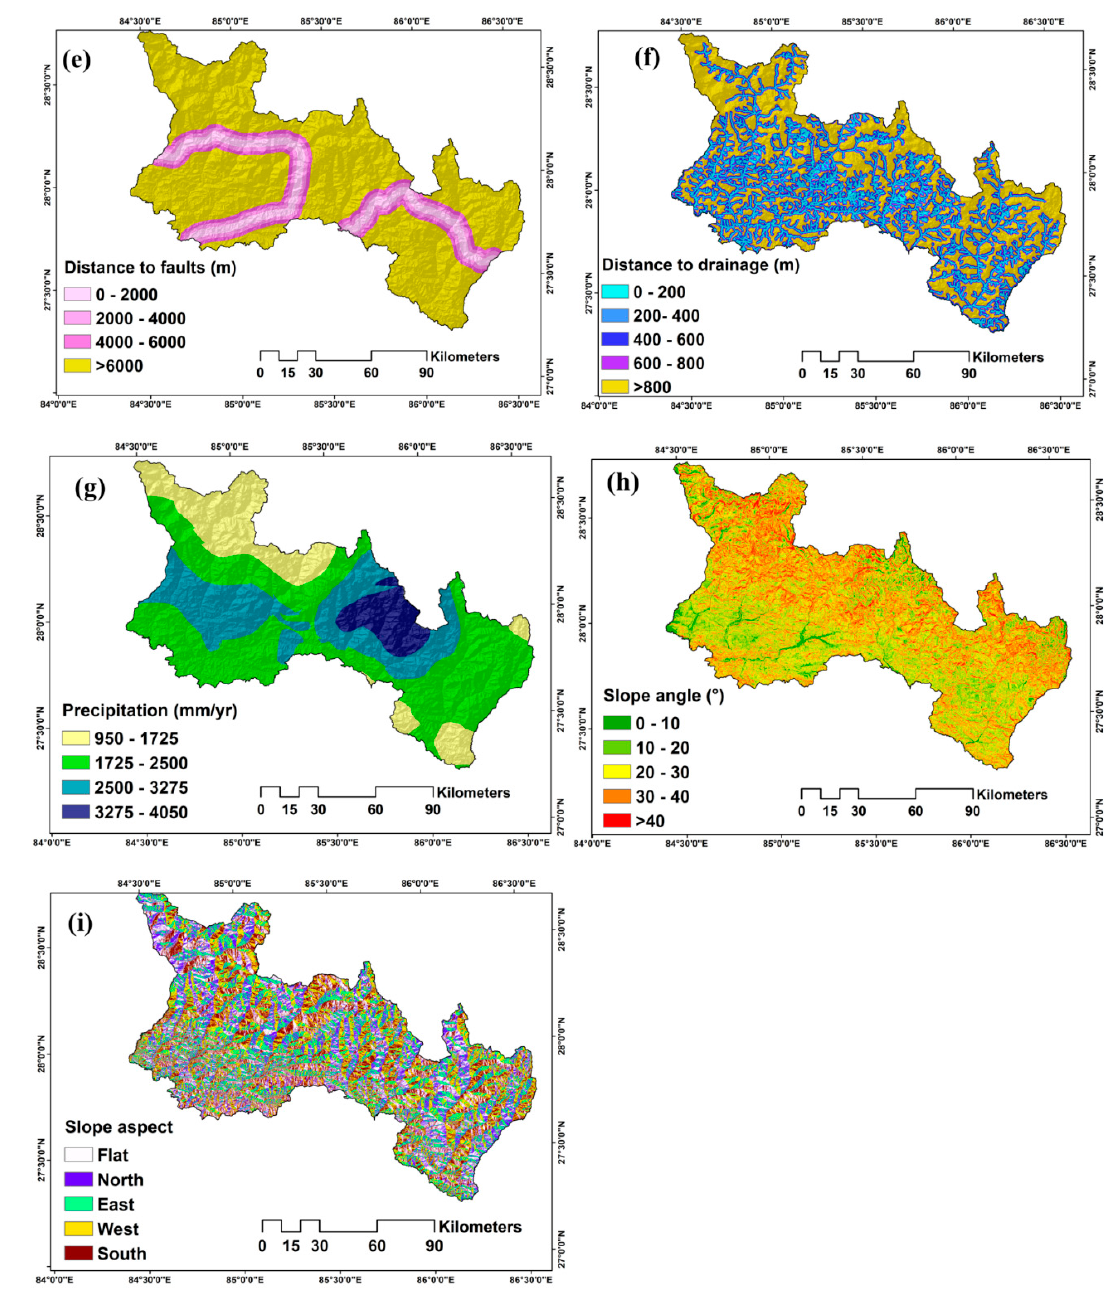
Figure 3. Thematic maps used in this study ( a ) land cover, ( b ) distance to roads, ( c ) elevation, ( d ) lithology, ( e ) faults, ( f ) drainage, ( g ) precipitation, ( h ) slope angle, and ( i ) slope aspect.